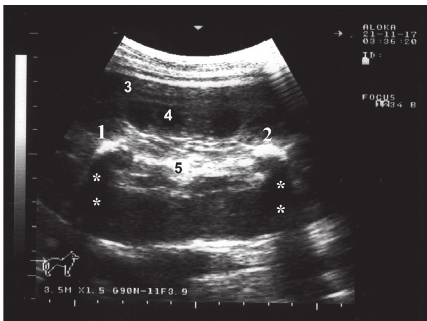
Figure 10: Nephrolithiasis (1 and 2) in a female camel with red urine for a 6-month period. 3, renal cortex; 4, renal medulla; 5, renal sinus. Stars point to acoustic shadowing under the